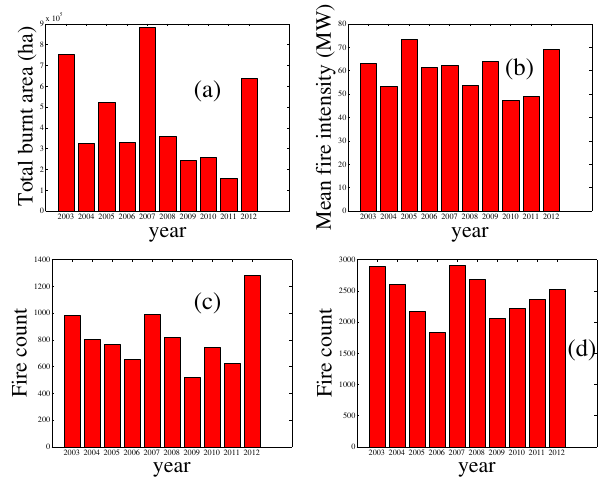
Figure 2. Total burnt area (a) , fire intensity (b) and fire counts as- sociated with BA (c) and FRP (d) detection for the 2003–2012 time period. BA detection is done using the MODIS MCD64